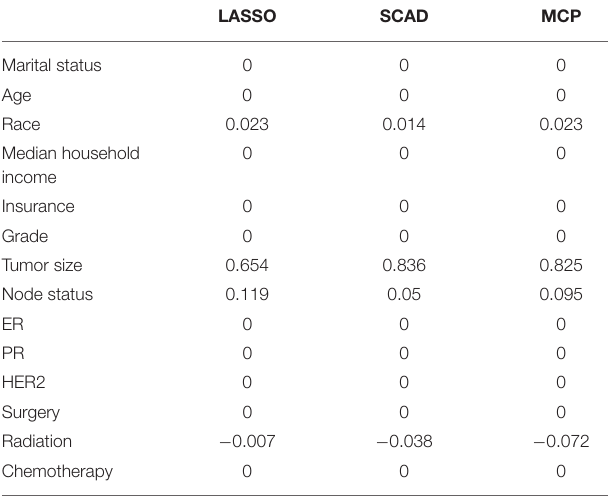
TABLE 4 | Variable selection based on estimated coefficients (SEs) by the SH